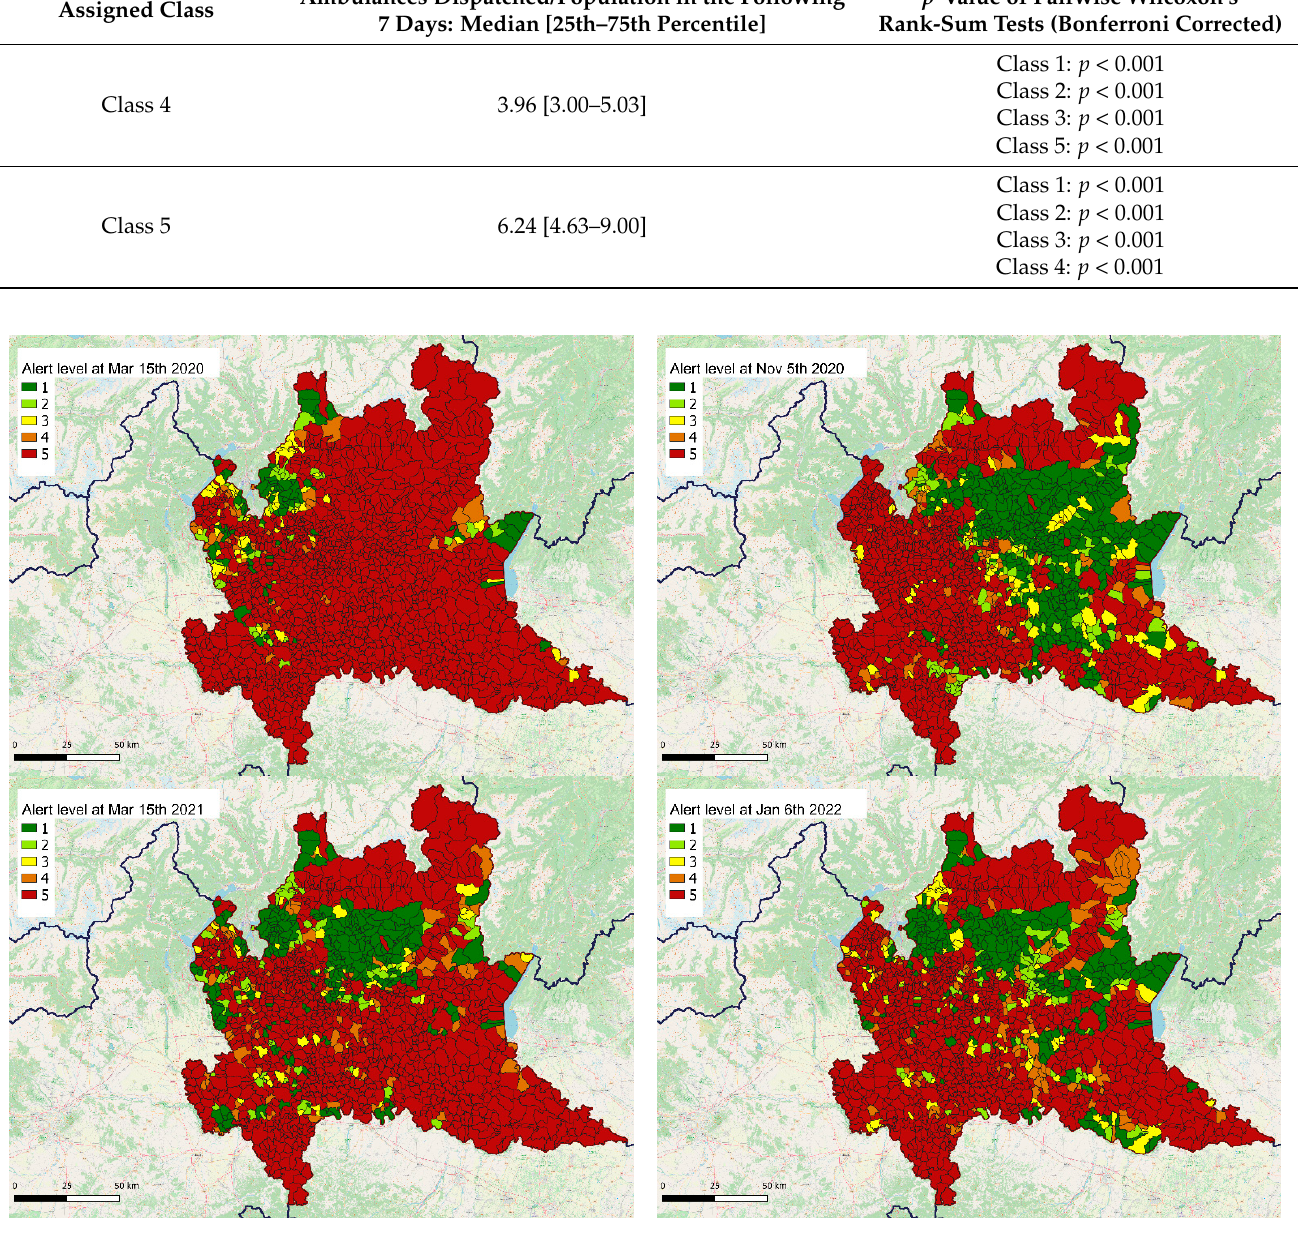
Figure 4. Map representation of the output of a machine learning model representing, for every municipality of Lombardy, Italy, the alert level of confidence, as expressed in five classes, of being in a condition of the active spreading of COVID-19, on the basis of a post-processing of the machine learning output. Four dates are here considered: 15 March 2020 ( top left ) as the peak of the first wave; 5 November 2020 ( top right ), as the first peak of the second wave; 15 March 2021 ( bottom left ), as the second peak of the second wave; and 6 January 2022 ( bottom right ) as the peak of the third wave.